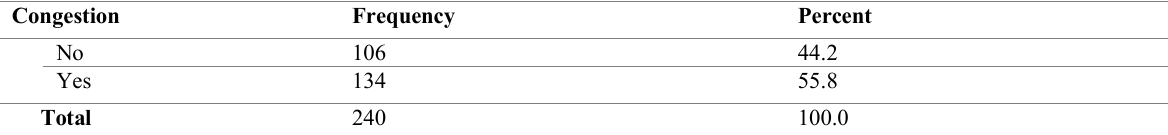
Table 1: Congestion in Out-Patient Department